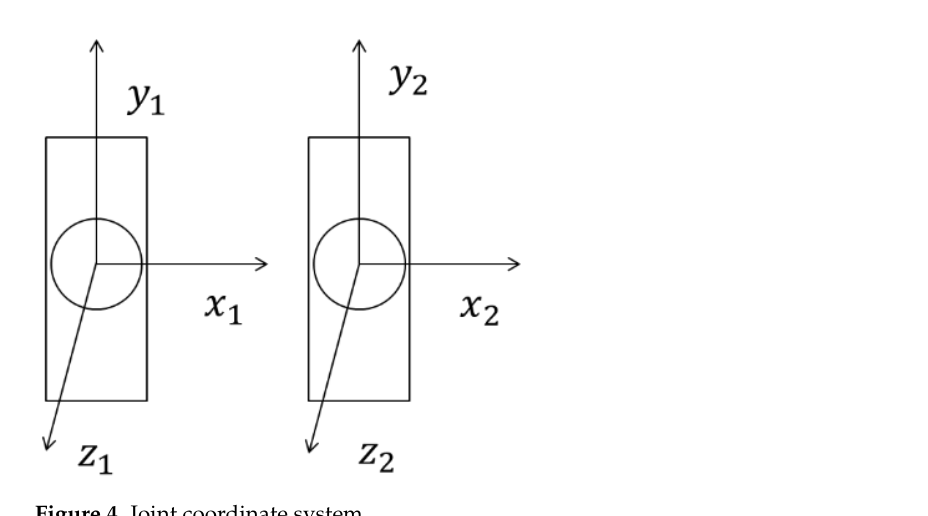
Figure 4. Joint coordinate